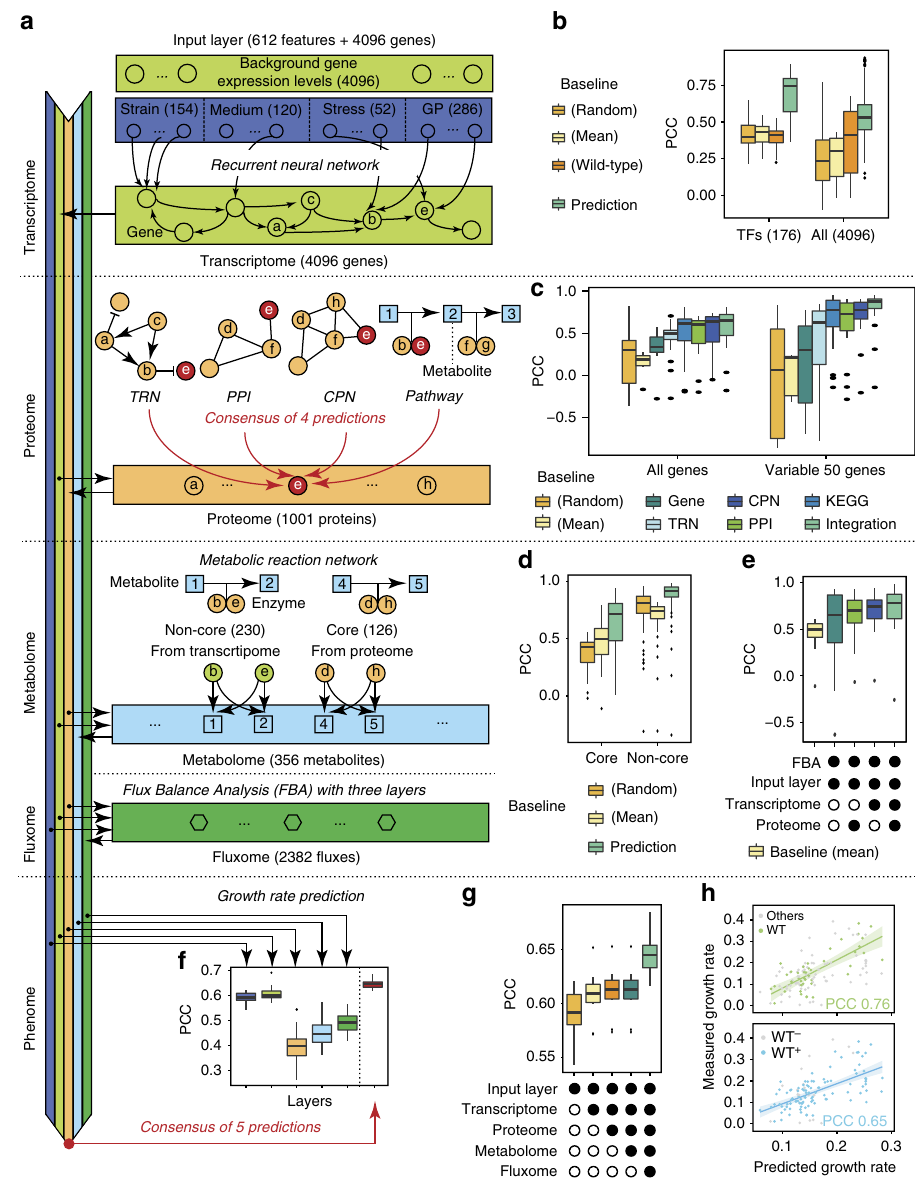
Figure 5 | Model architecture and prediction performance. ( a ) The data and work flow over the five modules, one for each layer. ( b ) Prediction performance of the transcriptome module for all 178 TFs and all genes. For TFs (PCC 0.68 ± 0.14, left panel), P o 10 (cid:2) 13 for random baseline (PCC 0.41 ± 0.09), P o 10 (cid:2) 13 for mean baseline (PCC 0.41 ± 0.07), P o 10 (cid:2) 14 for wild-type baseline (PCC 0.40 ± 0.07). For all genes (PCC of 0.54 ± 0.15, right panel), P o 10 (cid:2) 15 for random baseline (PCC 0.25 ± 0.17), P o 10 (cid:2) 15 for mean baseline (PCC 0.26 ± 0.14), P o 10 (cid:2) 15 for wild-type baseline (PCC 0.36 ± 0.22) ( c ) The prediction performance for the proteome module. The number of proteins for each module (all proteins; 50 most variable): TRN (250;20), KEGG (547;36), PPI (1000;50), CPN (847;50), Integration (1001;50). Baselines from linear protein inference from transcriptional level (PCC 0.34 ± 0.18, P o 10 (cid:2) 2 ), random (PCC 0.24 ± 0.34, P o 10 (cid:2) 2 ) and mean (PCC 0.16 ± 0.10, P o 10 (cid:2) 4 ) is shown. ( d ) Metabolite prediction (PCC 0.65 ± 0.21; 126 metabolites) from 75 protein expression levels in core metabolism (comparison with baselines: random, PCC 0.36 ± 0.13, P o 10 (cid:2) 6 ; mean, PCC 0.47 ± 0.19, P o 10 (cid:2) 3 ). Metabolite prediction (PCC 0.87 ± 0.15; 230 metabolites) in non-core metabolism from 4096 gene expression levels (comparison with baselines: random, PCC 0.77 ± 0.17, P o 10 (cid:2) 13 ; mean, PCC 0.70 ± 0.13, P o 10 (cid:2) 15 ). ( e ) Flux prediction, evaluated over 32 different conditions. Performance (PCC of 0.72 ± 0.24) was compared to that of FBA without other layers (PCC of 0.65 ± 0.39, P o 10 (cid:2) 1 ), without transcriptome (PCC of 0.67 ± 0.21, P o 10 (cid:2) 1 ), without proteome (PCC of 0.70 ± 0.20, P o 10 (cid:2) 1 ) and mean baseline (PCC of 0.50 ± 0.11, P o 10 (cid:2) 8 ). ( f ) Performance of growth rate prediction from each layer (input, transcriptome, proteome, metabolome, fluxome from left) and the consensus of predictions from five layers (right). Performance to random baseline is not shown (PCC ¼ (cid:2) 0.01; P o 10 (cid:2) 5 ) ( g ) Additive effect of additional layers in growth rate prediction. ( h ) Comparison of predicted growth rate and measured growth rates for 60 novel wild-type conditions (top) and for 101 conditions with wild-type information present in the training set (bottom). In all performance evaluation, three baselines are used: the random baseline represents prediction from mean expression level of randomly selected profiles in the training set; the mean baseline is the prediction from mean expression level of all profiles in the training set; the wild-type baseline is the prediction by mean expression levels of wild-type profiles in the training set. In all cases, leave-one-condition-out (LOCO) cross-validation was used. The error bar indicates standard error of the mean. Wilcoxon rank sum test was used for all statistical